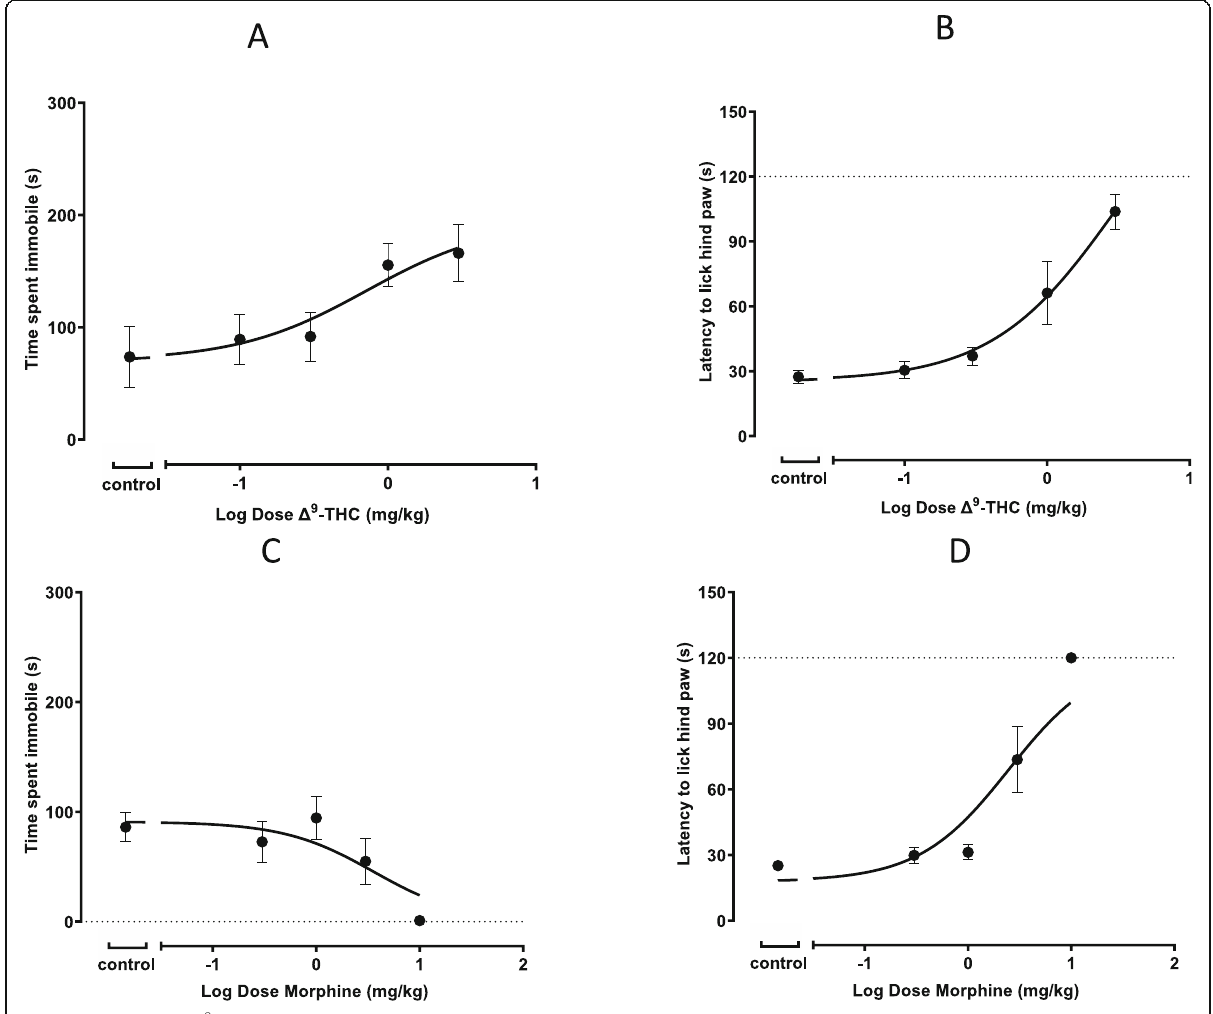
Fig. 2 The effects of Δ 9 -THC and morphine in each behavioral assay. Mice were intravenously dosed with control (vehicle) ( n = 7), 0.3 (n = 7, 1 animal excluded), 1 (n = 7), 3 mg/kg (n = 7) Δ 9 -THC (panel a ) or control (vehicle) (n = 7), 0.3 (n = 7), 1 (n = 7), 3 (n = 7), or 10 mg/kg (n = 7) morphine (panel c ) and immobility time in the tail suspension assay was evaluated 20 min post dose. The effects of Δ 9 -THC (n = 7 per group) (panel b ) and morphine (n = 7 per group) (panel d ) were evaluated 5 – 10 min post-dose in the standard hot plate assay. Note that the maximal duration is denoted as 120 s in this assay by the dotted lines (panels b and d ). Data is presented as the mean ± SEM. Data were fit using a 3 parameter log (agonist) vs. response non-linear regression